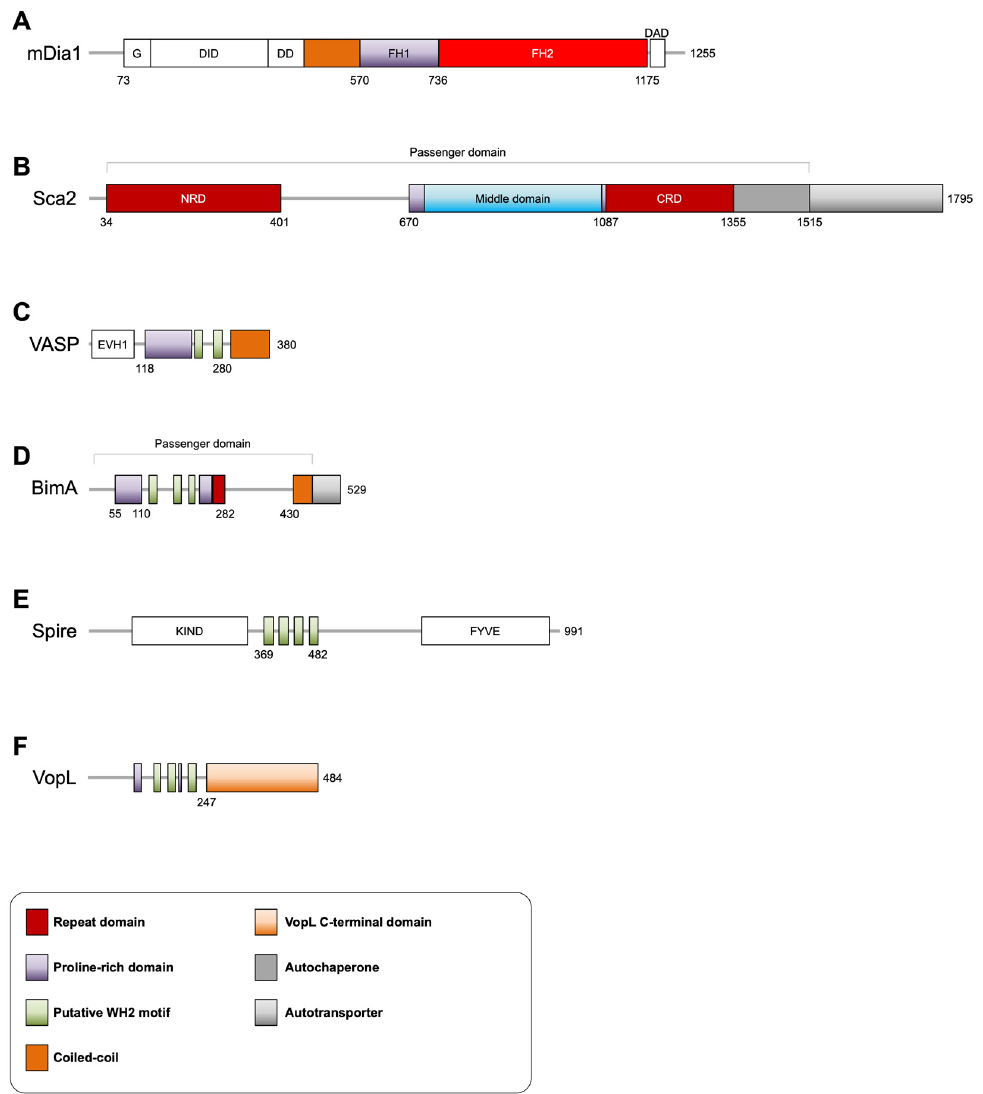
Figure 1. Domain organization of eukaryotic actin assembly factors and their pathogen effector mimics. ( A ) The domain organization of the formin mDia1 (mouse, Uniprot O08808) and ( B ) its pathogen mimic Rickettsia conorii Sca2 (Uniprot Q92JF7). ( C ) The domain organization of VASP (human, Uniprot P50552) and ( D ) its pathogen mimic Burkholderia pseudomallei BimA (Uniprot B9U4V1). ( E ) The domain organization of Spire (Drosophila, Uniprot Q9U1K1-1) and ( F ) its pathogen mimic Vibrio parahaemolyti- cus VopL (Uniprot Q87GE5). Domain abbreviations are as follows: G (GTPase-binding domain),